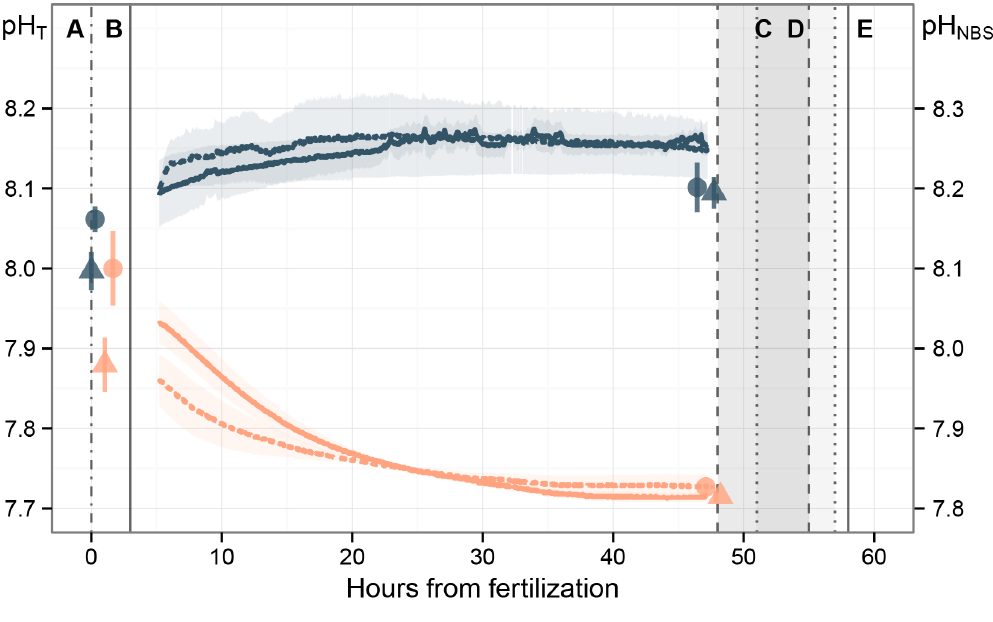
Figure 2. Seawater pH in experimental cylinders over the larval experiment. Points with error bars show mean pH ( ± 0.5 σ ) derived from spectrophotometer measurements 0.5 h T and 47.5 h after fertilization (left y-axis scale). Lines show average pH measured NBS with sensors from two cylinders per treatment combination (shading: ± 0.5 σ ; right y-axis scale). Light orange refers to the high p CO treatment (TSW) and dark blue to the control 2 (CSW). Dots and solid line refer to the low, and triangles and dotted lines to the high temperature treatment. Dot-dashed vertical line shows the time of fertilization (A), solid line the time when embryos were introduced (B), dark gray shading between dashed lines the time frame of calcification measurements (C), light gray shading between dotted lines the time of metabolism measurements (D; C and D overlapped, hence the dark grey zone), and solid line both, the end of the larval experiment, and the time of larval size and survival measurements